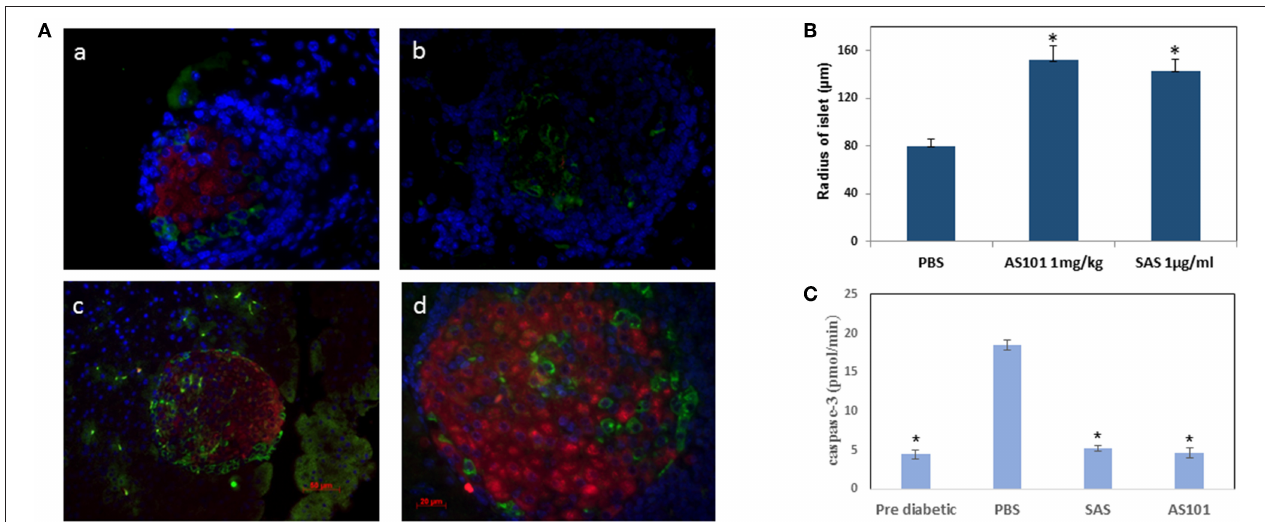
FIGURE 9 | AS101 and SAS prevent islet damage and preserve islet function. (A) AS101 or SAS at 1 mg/kg/injection were administered i.p. every other day to female NOD mice, starting at 3 weeks of age. At 20 weeks, pancreatic heads were fixed and stained for insulin (red), glucagon (green), and nuclear staining (blue). Pancreata from 5 week old mice (pre-diabetic) served as a control. (a) Pre-diabetic; (b) PBS; (c) AS101; (d) SAS. The results are representative of 3 mice/group. 10 slides/mouse were visualized. X400. (B) Microscopic determination of islet radius. Results represent means ± SE of 5 mice/group. * p < 0.01 vs PBS. (C) Pancreas cell lysates from 20w old mice were analyzed for caspase-3 activity by colorimetric assay. Results represent means ± SE of 5 mice/group. * p < 0.01 vs. all groups.